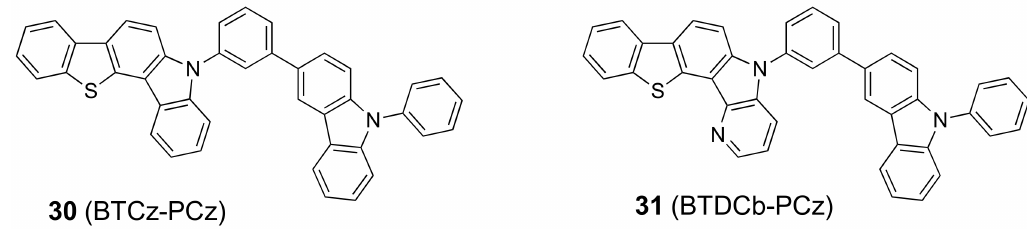
Figure 9. Materials used to initiate an exciplex TADF